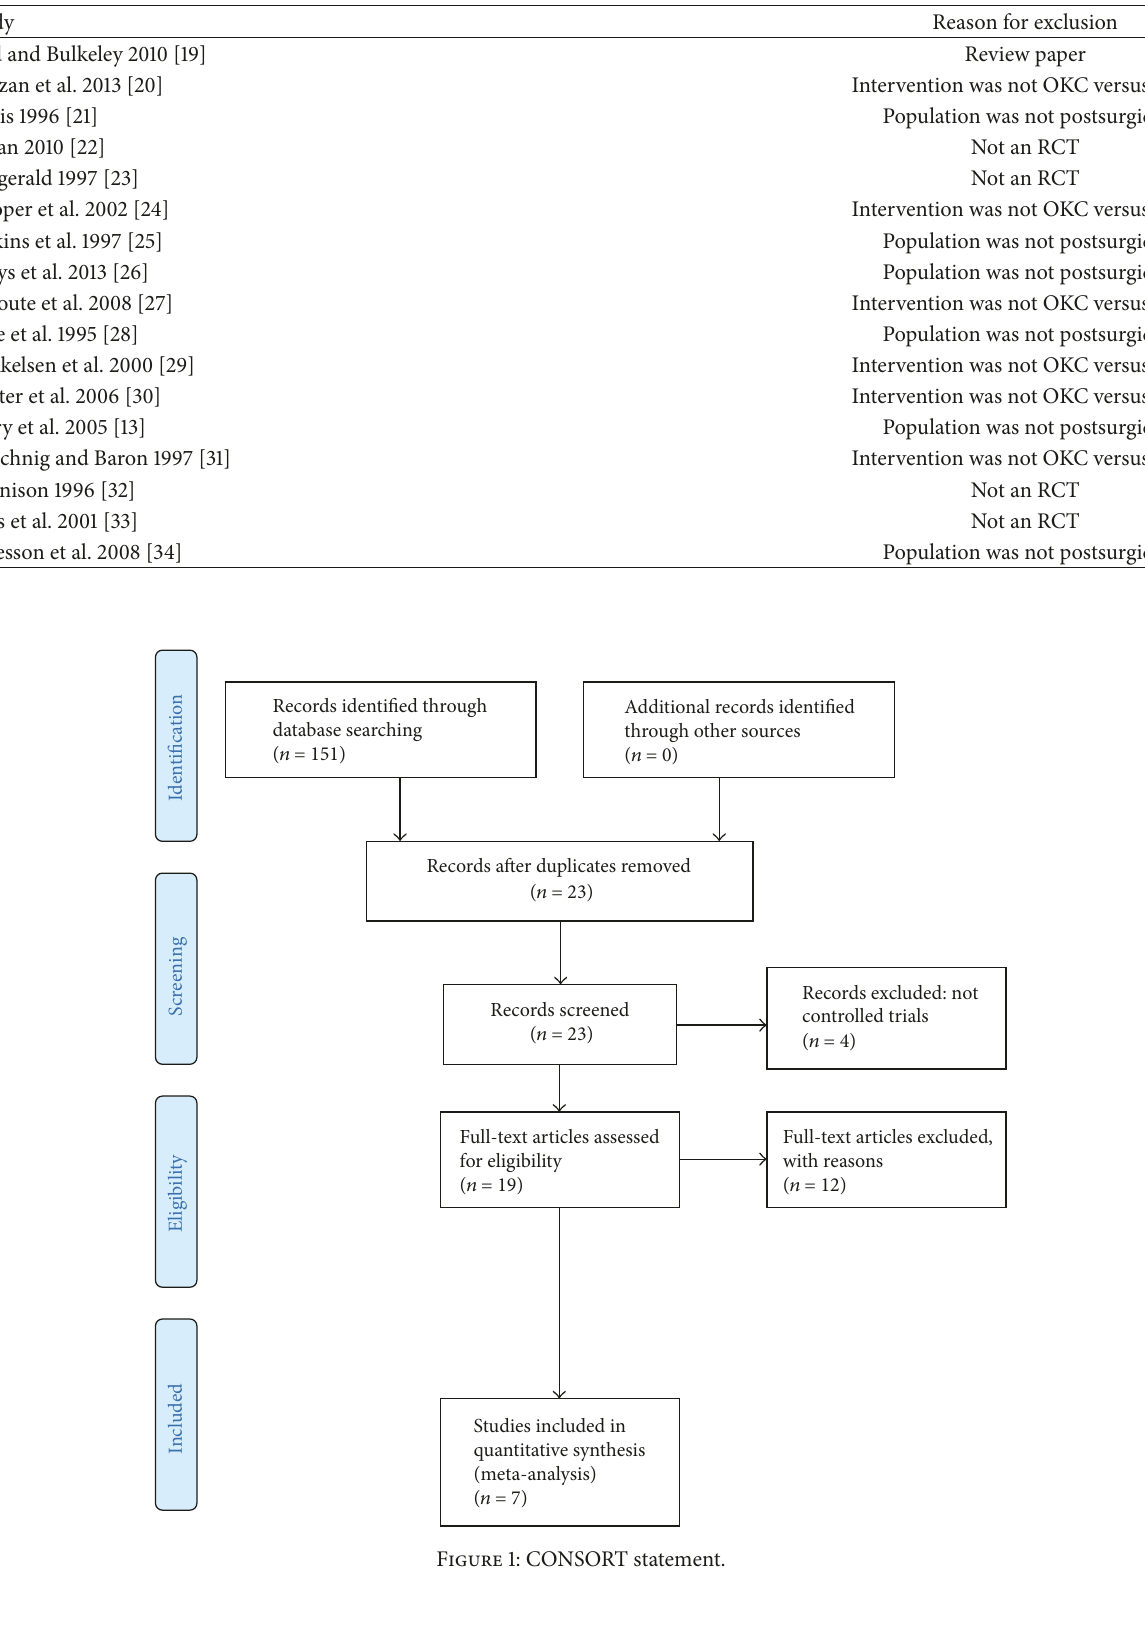
Table 2: Excluded studies.